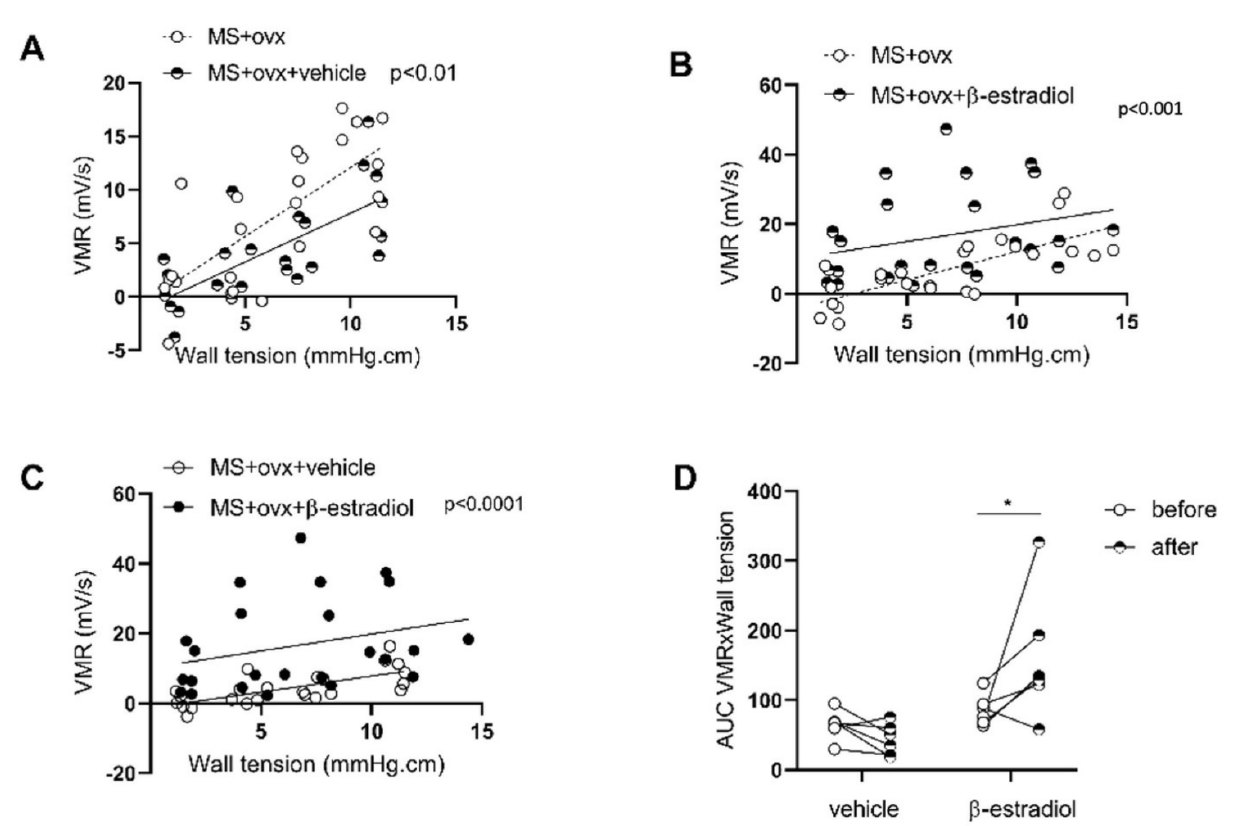
Figure 5. Effect of estrogen supplementation in ovariectomized MS females on colonic sensitivity. Colonic sensitivity was assessed by testing the elevation of linear regression curves using a Fisher test between MS ovariectomized females before and after injections of vehicle ( n = 6) ( A ), between MS ovariectomized females before and after injections of β -estradiol ( n = 6) ( B ) and between MS ovariectomized females injected with vehicle or β -estradiol ( C ). Individual representation of the effect of the treatment tested with a two-way ANOVA comparing paired time point ( D ). * p < 0.05.